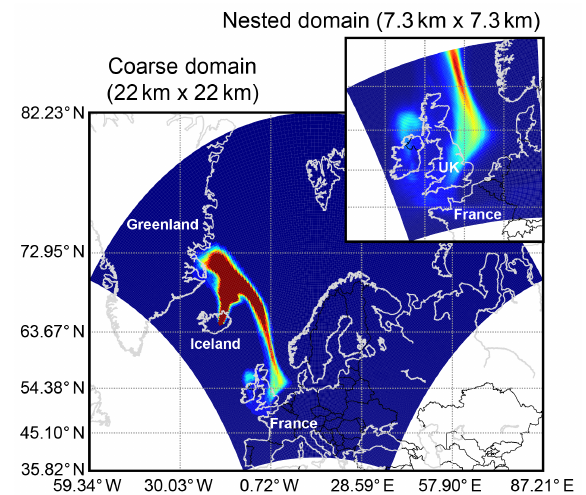
Figure 10. Nested horizontal domains of high spatial resolution simulations: coarse resolution (22km × 22km) and nested high res- olution (7.3km × 7.3km) (in inset)